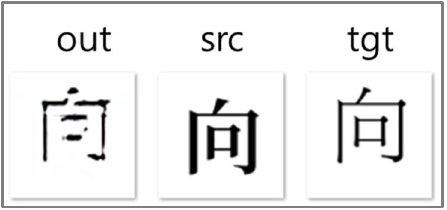
Figure 22. Failure examples of a character. Out, src, and tgt represent output, source, and target images, respectively.